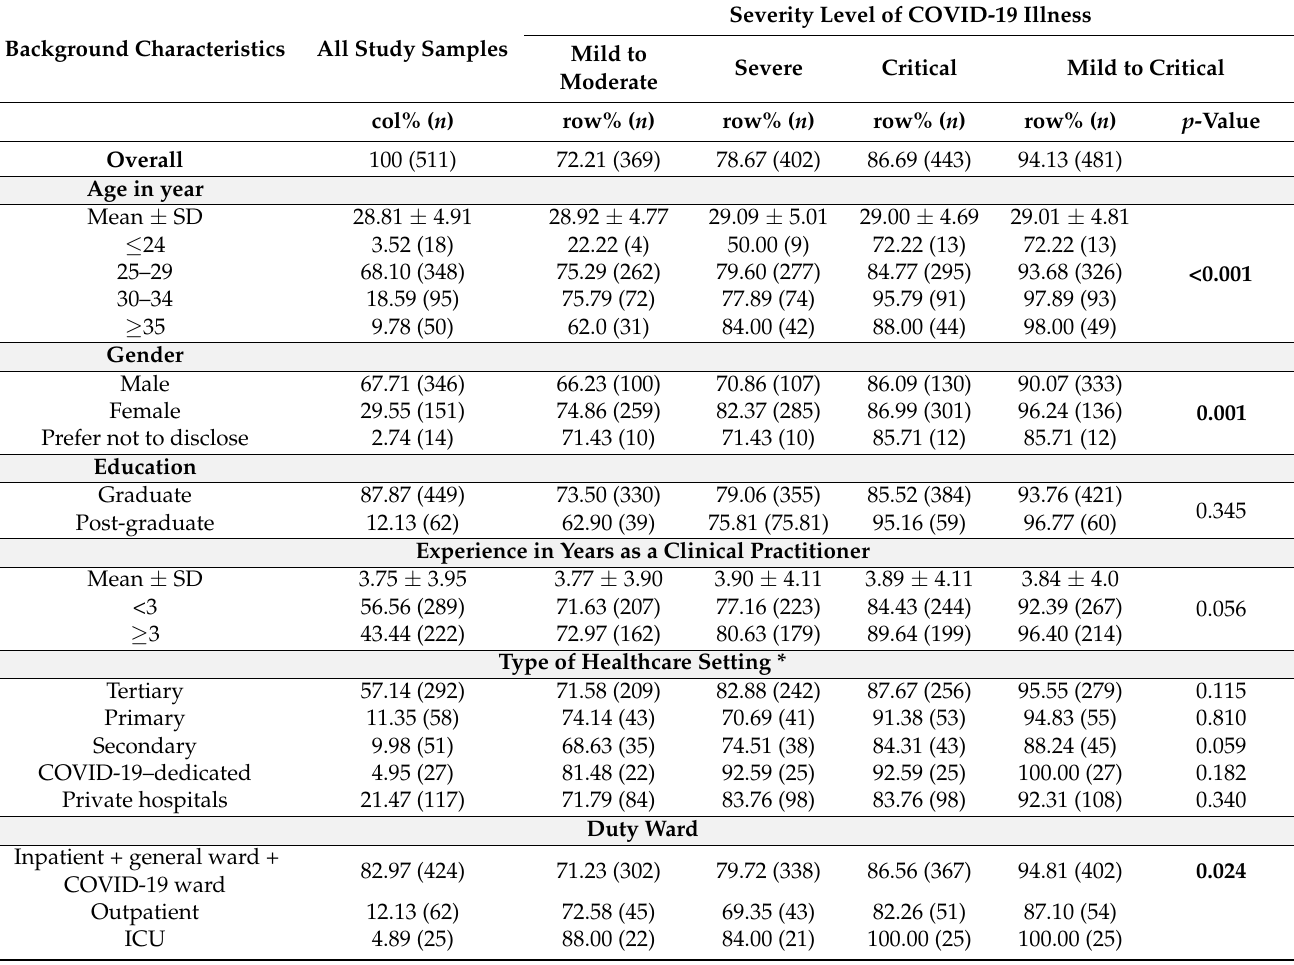
Table 1. Demographic characteristics of the study physicians, 2021